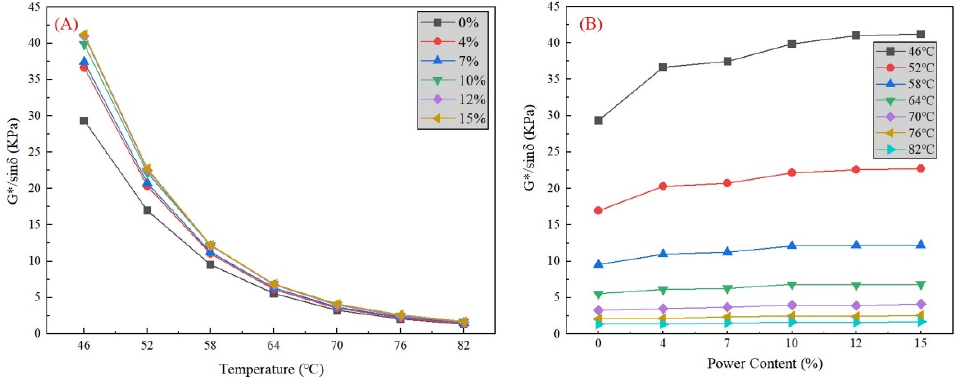
Figure 9. Variation of rutting factor G*/sin δ with different ( A ) test temperature, and ( B ) mineral powder content.